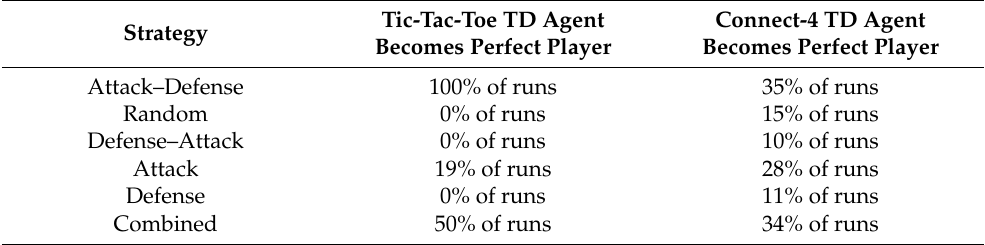
Table 2. Percentage of simulation runs in which the TD agent becomes the perfect player.